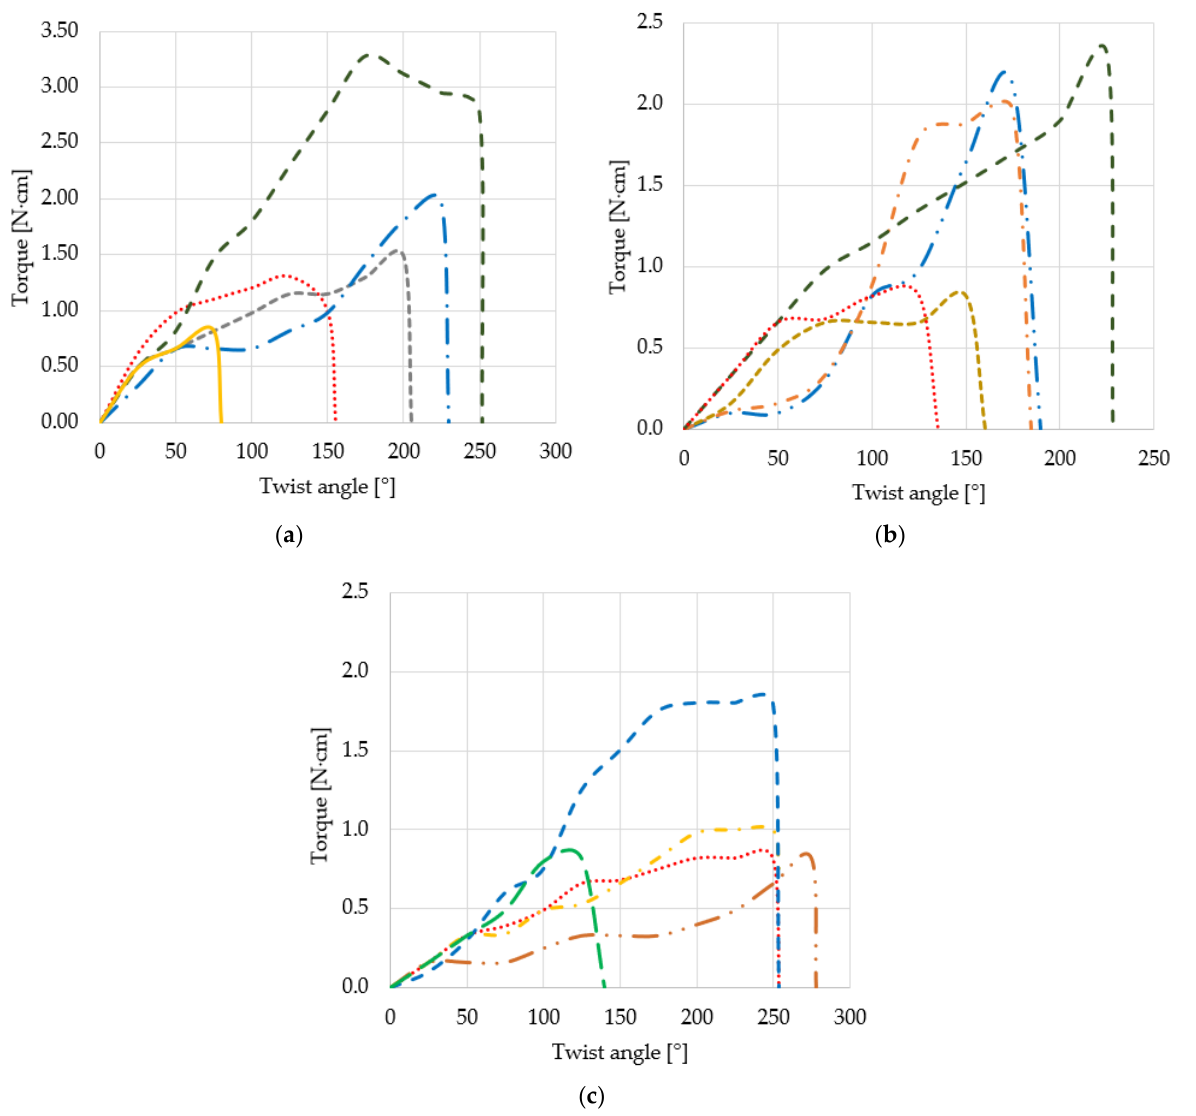
Figure 5. The diagrams of the torsion torque T (N·cm) versus the twisting angle θ (°) determined for the samples of ( a ) Group Endostar, ( b ) Group Reciproc, and ( c ) Group Protaper. Table 1. Measured values of the torsional torque T max and twisting angle θ max at fracture point for each instrument of the three study groups—according to Figure 5.